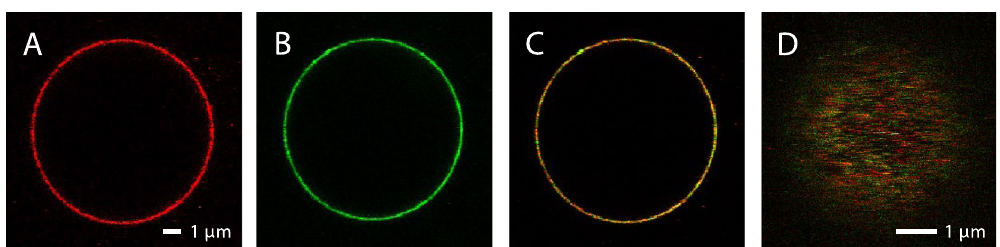
Figure 2. Confocal scanning microscope images of a GUV in which two fluorophore-labeled proteins were reconstituted. ( A ) Detection of cyt. bo 3 labeled with ATTO 647N. The focal plane is at the middle of the vesicle. ( B ) Detection of ATP-synthase labeled with ATTO 594. ( C ) Combined image of ATTO 594 and ATTO 647N detection. ( D ) An image of the top of the vesicle, which is the focal plane used for the FCS measurements. The lipid composition of the vesicle was 99% DOPC and 1% DPPE functionalized with a biotinyl head group. The GUVs were immobilized on a streptavidin-coated cover slide and the solution around the vesicle was 10 mM HEPES pH 7.4, supplemented with 10 mM NaCl and 100 mM